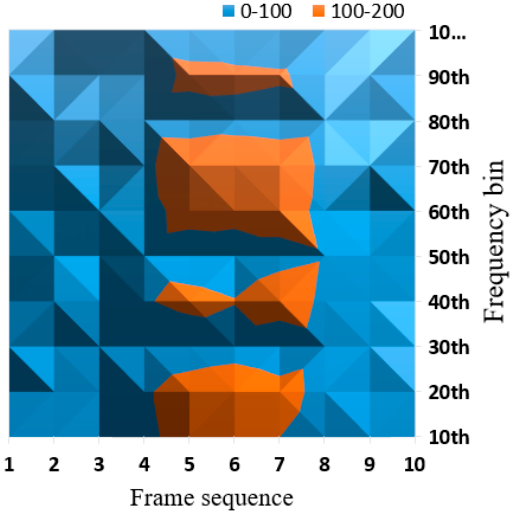
Figure 5. Tendency of spectral energy variation over time.